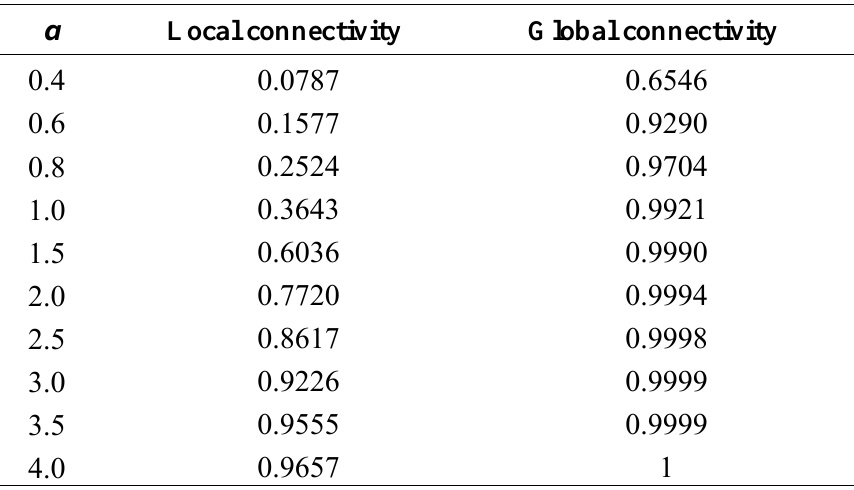
Table 2 . Network